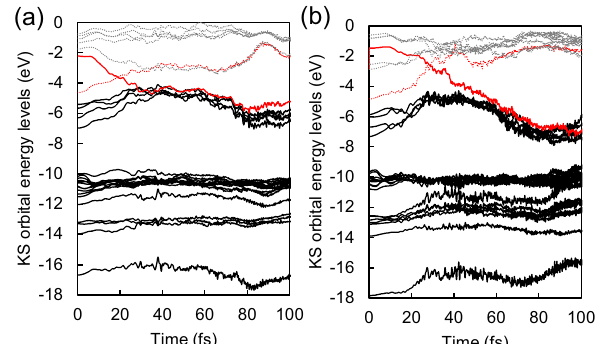
Figure 4. Time evolution of spin-up KS orbital energy levels driven by ( a ) HOMO-to-LUMO excitation and ( b ) HOMO-to-LUMO + 2 excitation. Solid lines and dotted lines are associated with occupied states and empty states, respectively. The red lines indicate time-evolving energy levels of the initial HOMO and ( a ) LUMO [( b ) LUMO + 2] states. Internal conversion to the electronic ground state happens within 50 fs in both cases.